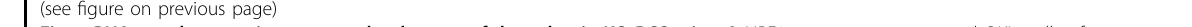
Fig. 5 BHA supplementation rescues the damage of the colon in KO-DSS mice. A NRF2 protein expression in shQKI5 cells, after treating with BHA (100 μ M) for 4 h, was detected by western blotting. B Quali fi cation of the band intensity of NRF2. C q-PCR detected the mRNA expression level of Gclc , Gsta1 , Hmox1 , Sod1 , Nqo1 , and Cat after BHA treatment. D Mice of WT and KO were randomly divided into two groups ( n = 5/group) and one group was administered with 3% DSS in drinking water for 7 days after receiving BHA (200 mg/kg) for 3 days by oral gavage while the other group was just treated with 3% DSS for 7 days. Body weight changes of each group were recorded daily. E Morphology of colons from WT and KO mice with or without BHA treatment. Colon lengths were measured on day 9. F Representative iNOS immunohistochemical staining of colon specimens obtained from KO mice with BHA treatment. Scale bars: 200 μ m. G PAS-stained images of colon sections. Black arrows pointed to the PAS-positive cells. Scale bars: 200 μ m. H Occludin, MUC1, and ZO-1 proteins from control mice and mice after BHA treatment were analyzed by western blotting. I Quali fi cation of the band intensity of occludin, MUC1, and ZO-1 from three independent experiments. J q-PCR analyzed the mRNA expression level of Defa-4 , Defa-5 , Camp , and Lyz in colon tissue after BHA treatment. K q-PCR analyzed the mRNA expression level of Il-1 β , Il-6 , Il-23 , and Tnf- α . All bars represent the mean of measurements from three independent experiments, and the error bars indicate ±SEM; * P < 0.05, ** P < 0.01, *** P < 0.001. Two- tailed Student ’ s t test ( B , C , F , G , I – K ) and one-way ANOVA ( D , E